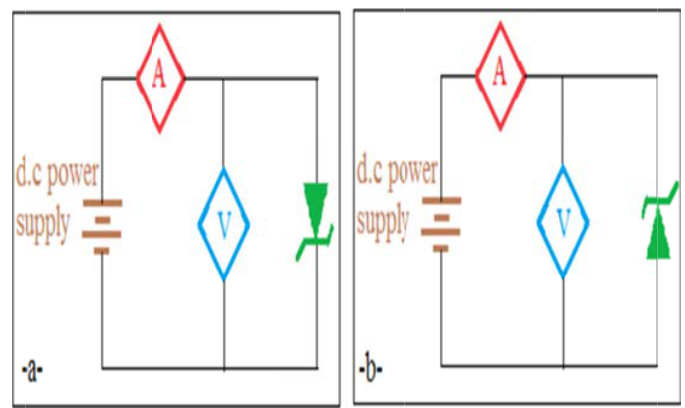
Fig g. 3: The circ Res sults and di T The SEM i (Zn O) of hete osited on p dep tech hnique at Fig. .4, where,